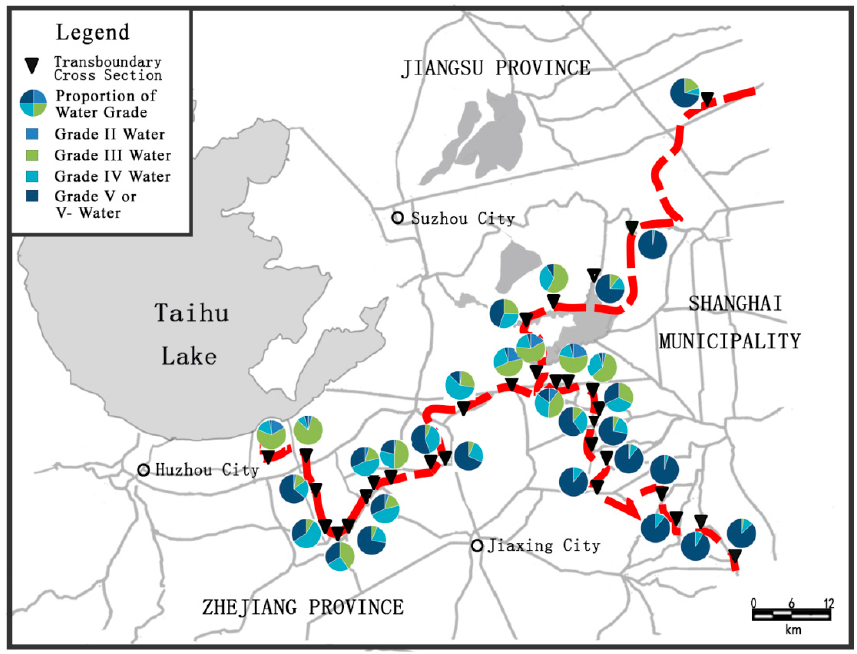
Figure 2. Spatial variation of water quality at trans-boundary cross sections in research area.